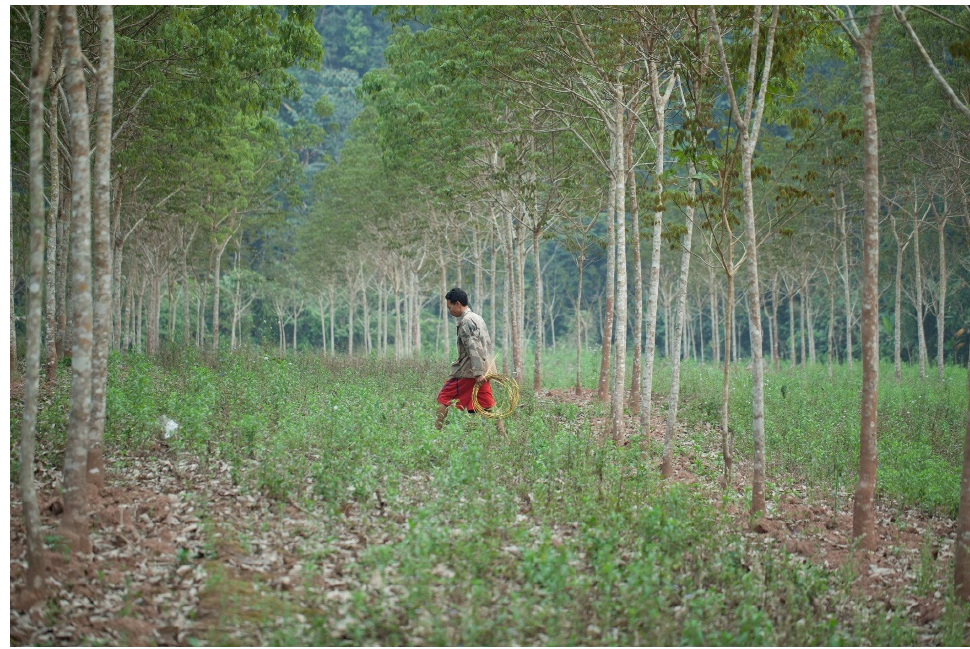
Figure 1. Replacement of native species by invasive Eupatorium adenophorum , forming a monoculture in the understory of a plantation in SW China. Photo credit: XiaoXue Mo.